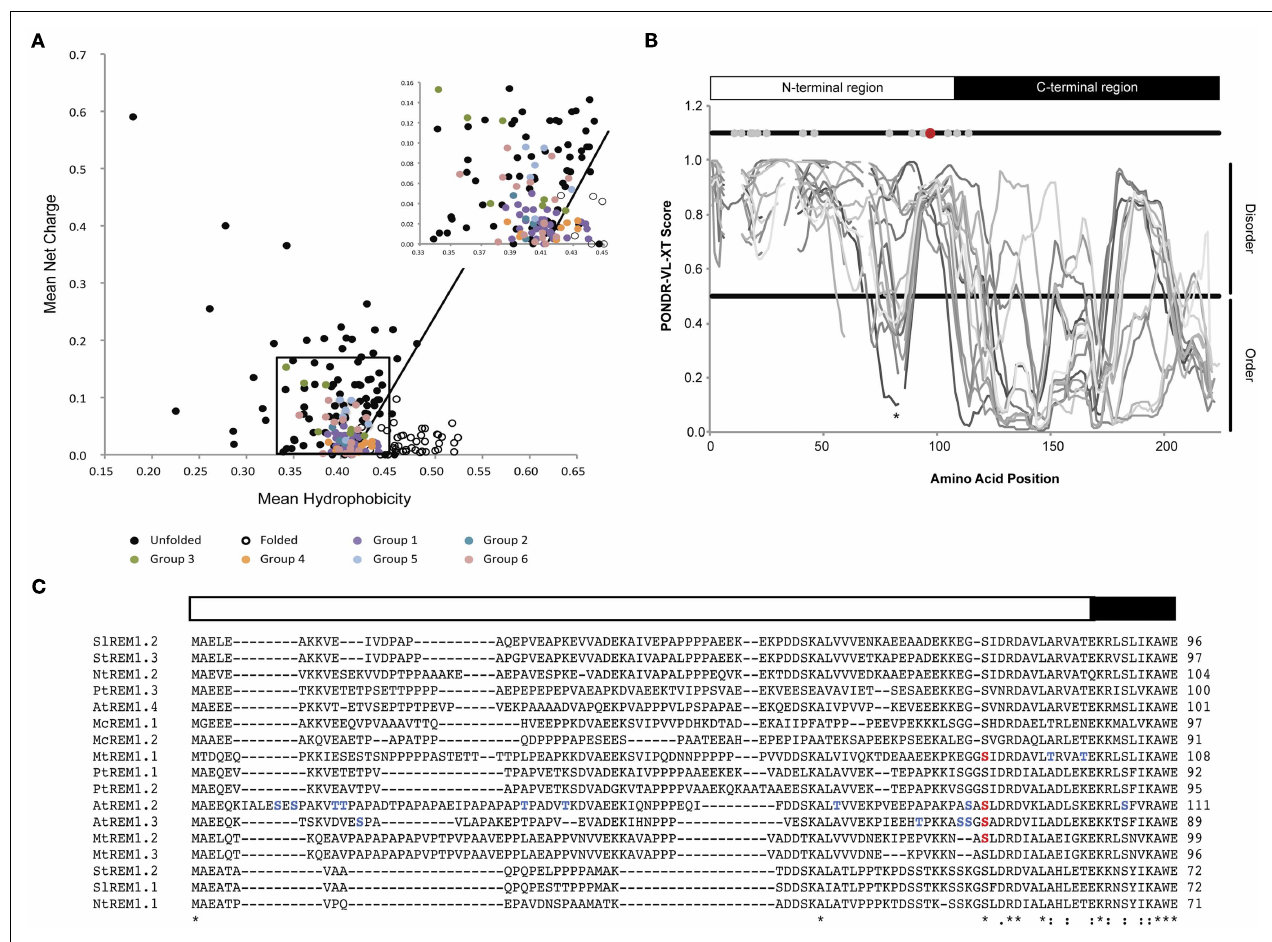
and black bars depict N- and C-terminal regions, respectively. Gray dots indicate residues that have been found to the phosphorylated in AtREM1.2, AtREM1.3, MtREM1.1, and MtREM1.2.The red dot indicates the residue that was described to be phosphorylated and conserved among all group 1b remorin proteins.The asterisk marks a conserved region of order within the disordered N-terminal region. (C) Protein alignment of group 1b remorin proteins.The alignment was performed using the ClustalW algorithm on the full-length protein sequences. For simplicity only the N-terminal region and the first residues of the C-terminal region are shown. Non-conserved phosphorylation sites are depicted in blue, whereas the conserved phospho-serine residue is indicated in red. Asterisks ( ∗ ) indicate positions that have a single, fully conserved residue. A colon (:) indicates conservation between amino acids with highly similar chemical properties. A period (.) indicates conservation between amino acids with weakly similar chemical